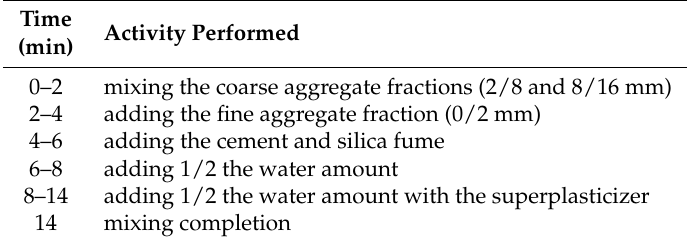
Table 4. Mixing procedure for concrete mixture